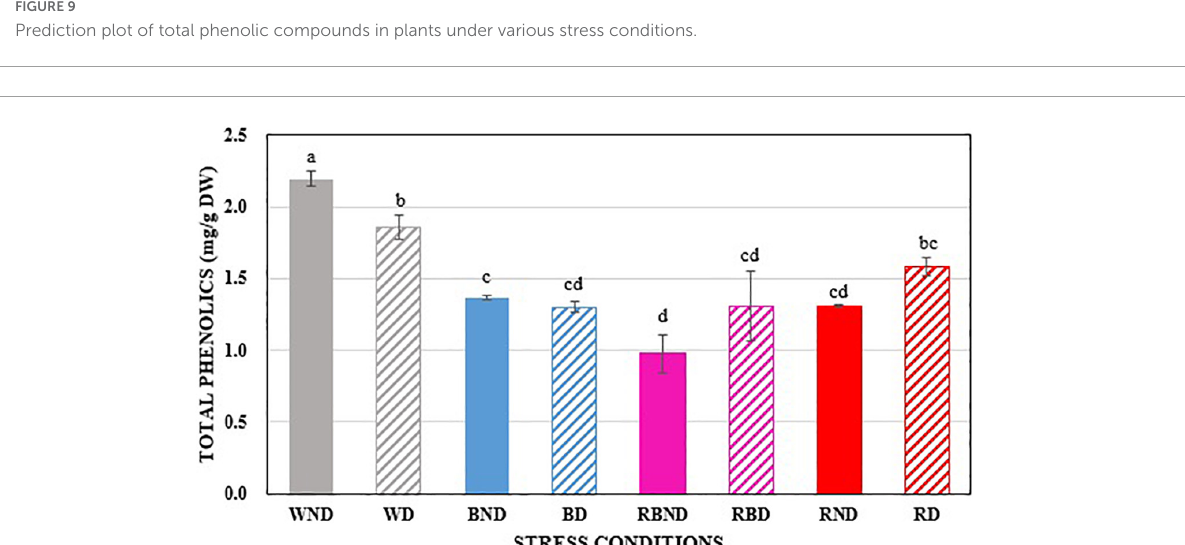
FIGURE10 The comparison of total phenolic compounds in plants under various stress environments. The different letters above the error bars denote the significant difference ( p < 0 . 005) between the parameter areas using Duncan’s multiple range test ( n = 3, mean ±